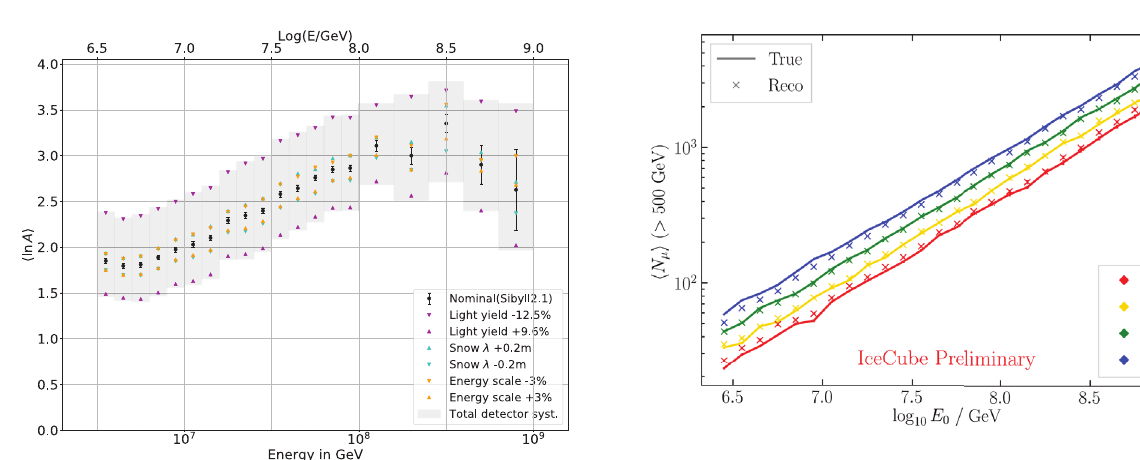
(cid:4) N (cid:5) is shown as a function of the primary energy E μ